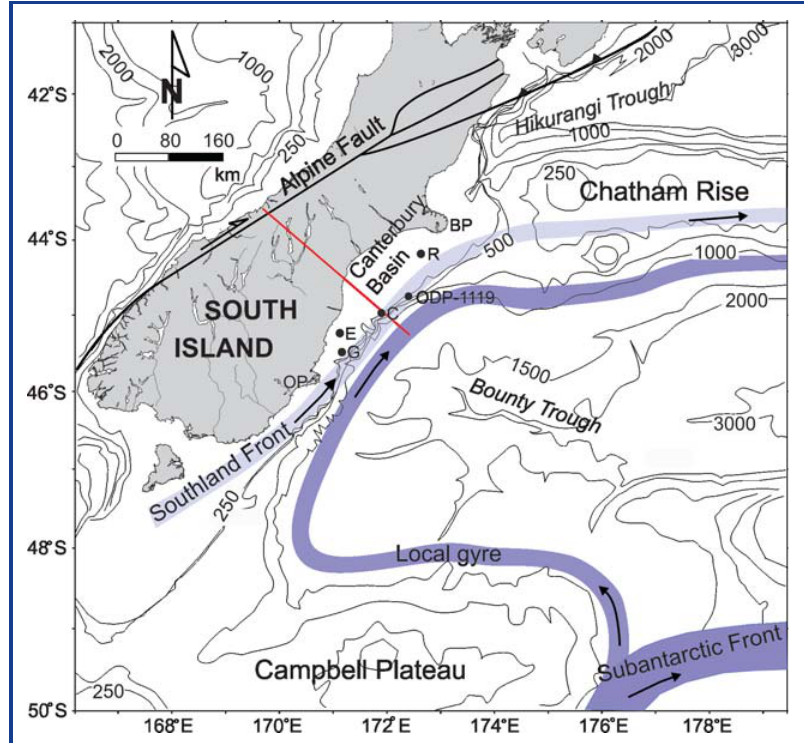
Figure 1. The Canterbury Basin underlies the present-day onshore Canterbury Plains and offshore continental shelf. It is bounded by the Miocene volcanic centers of the Banks Peninsula (BP) to the northeast and the Otago Peninsula (OP) to the southwest, and faces the Bounty Trough to the southeast. The Alpine Fault is the boundary between the Australasian and Pacific plates. Locations of the modern Southland Front and Subantarctic Front, together with local gyre within the Bounty Trough, are shown (Chiswell, 1996; Shipboard Scientific Party, 1999; Morris et al., 2001). Also shown are exploration wells in the offshore basin (Resolution, R; Clipper, C; Endeavour, E; and Galleon, G) as well as ODP Site 1119. The red line marks the approximate location of the schematic cross-section in Fig. 3. Bathymetric contours are in